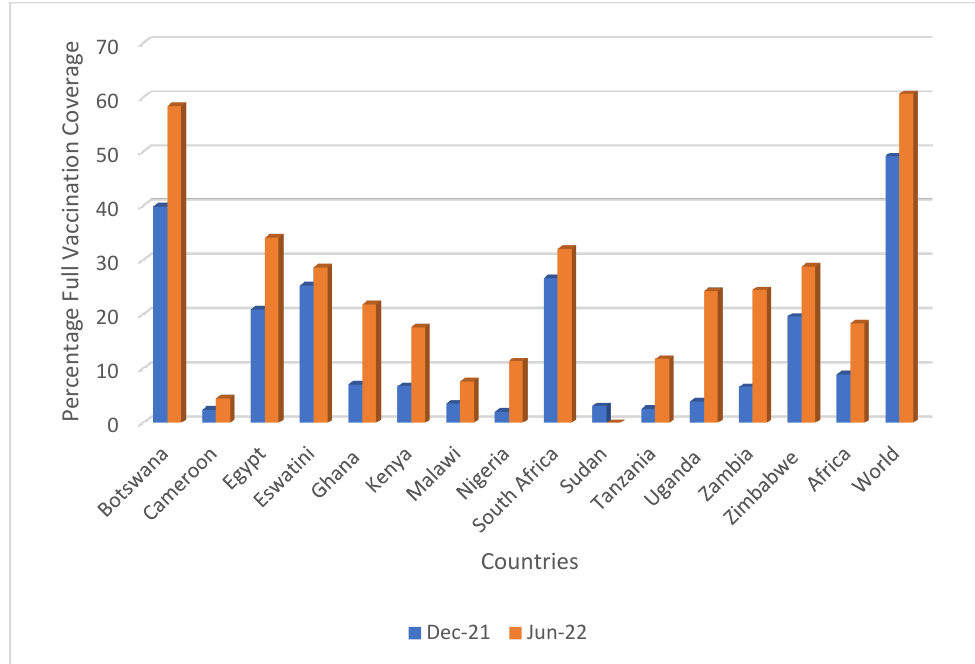
Figure 1. Changes in full vaccination coverage between December 2021 and June 2022. NB: DEC-21-F = fully vaccinated by protocol as of 31 December 2021, JUN-22-F = fully vaccinated by the protocol as of 30 June 2022. Based on [143 – 145,160].